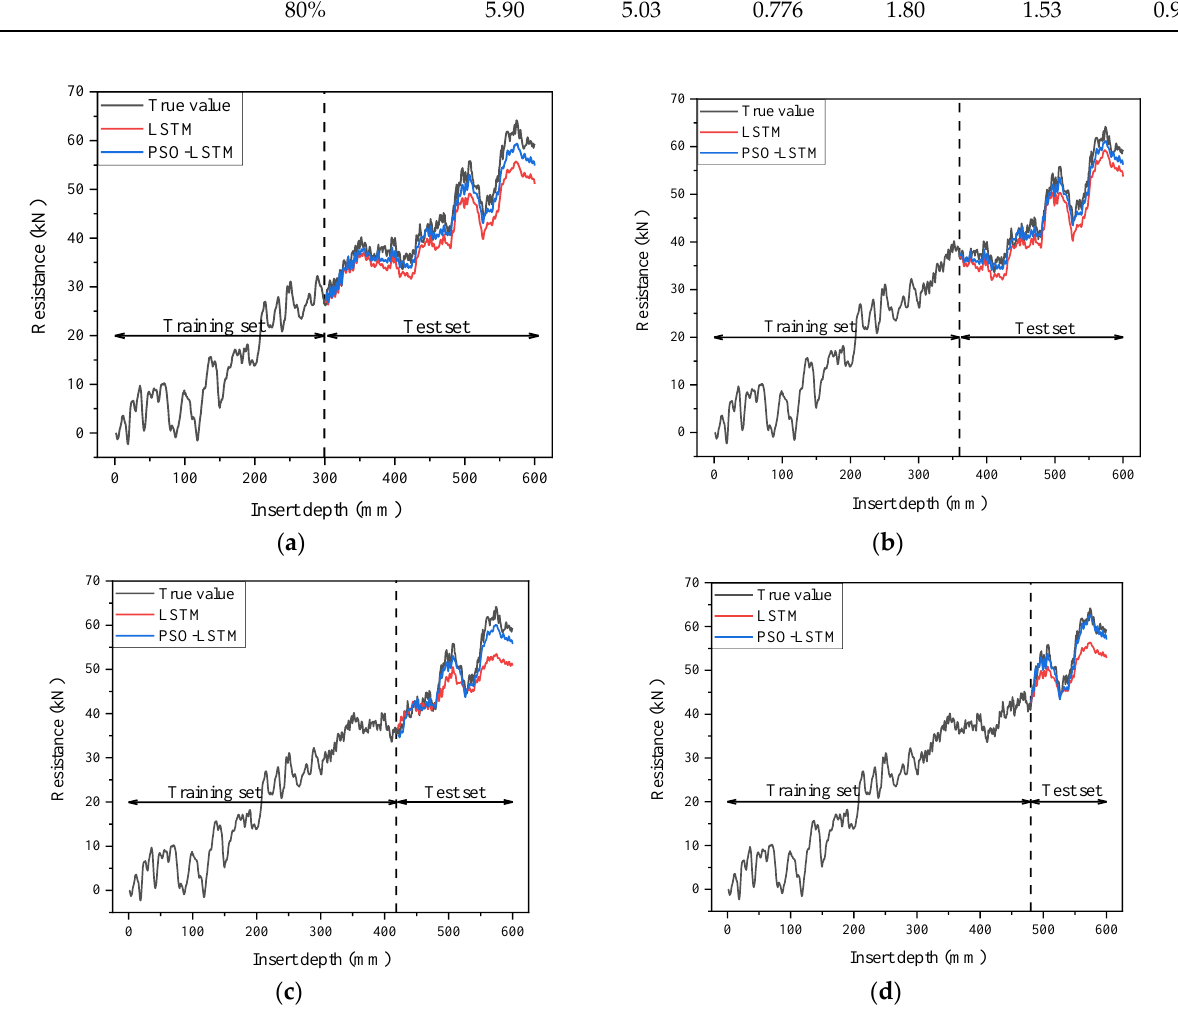
Figure 17. Gravel samples with an insertion depth of 600 mm. ( a ) The training set proportion of 50%; ( b ) The training set proportion of 60%; ( c ) The training set proportion of 70%; ( d ) The training set proportion of 80%.